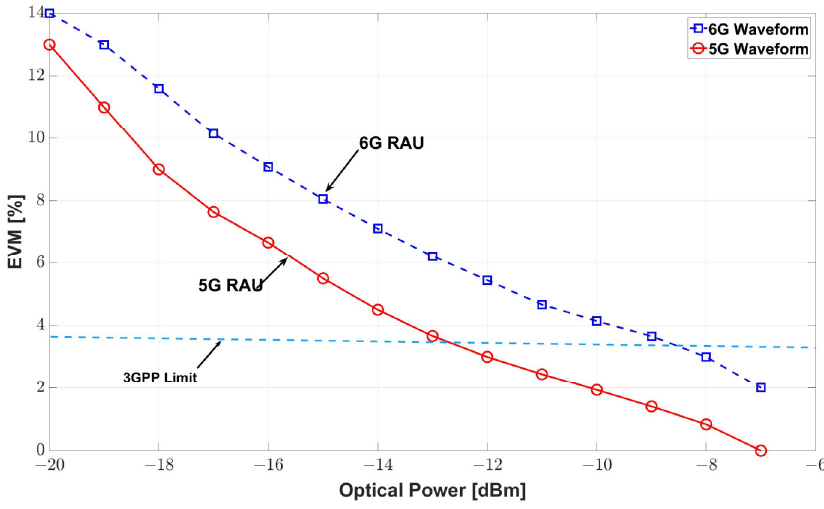
Figure 8. EVM vs. optical power for 5G and 6G signals at respective RAUs.